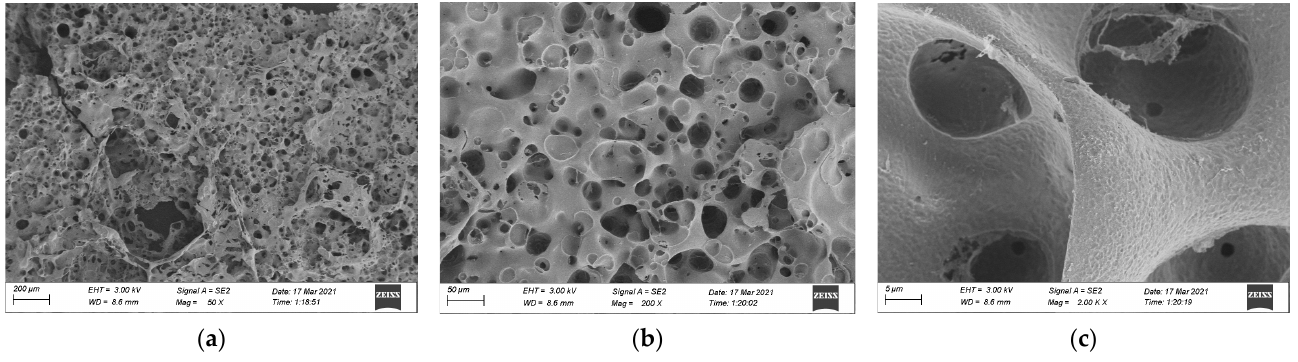
Figure 15. Morphology of carbon residue after the cone calorimeter test of epoxy asphalt: ( a ) 50×, ( b ) 200×, and ( c ) 2000× magnification.